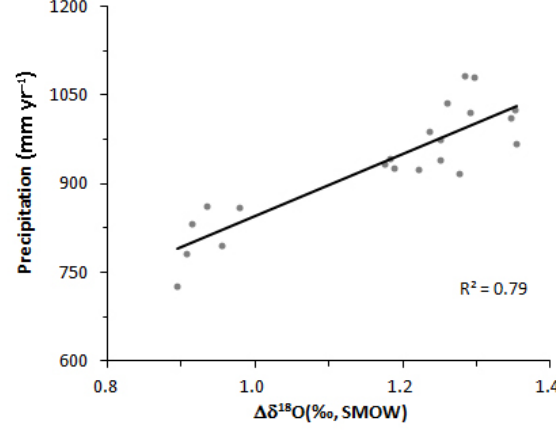
Figure 4. Correlation analysis between mean annual precipitation and drip water δ 18 O difference from 2-month delayed LF6 and 4- month delayed HS4 from May 2011 to April 2014. The (cid:49)δ 18 O data are calculated from monthly monitored data from Liangfeng cave and Heshang cave (Duan et al., 2016). The annual precipita- tion data are the average from six sites between Dongge cave and Heshang cave detailed in Hu et al. (2008a), and the original monthly rainfall data are from http://www.wunderground.com/history/. The correlation factor of 0.79 indicates a significant positive correlation between regional annual rainfall and annual (cid:49)δ 18